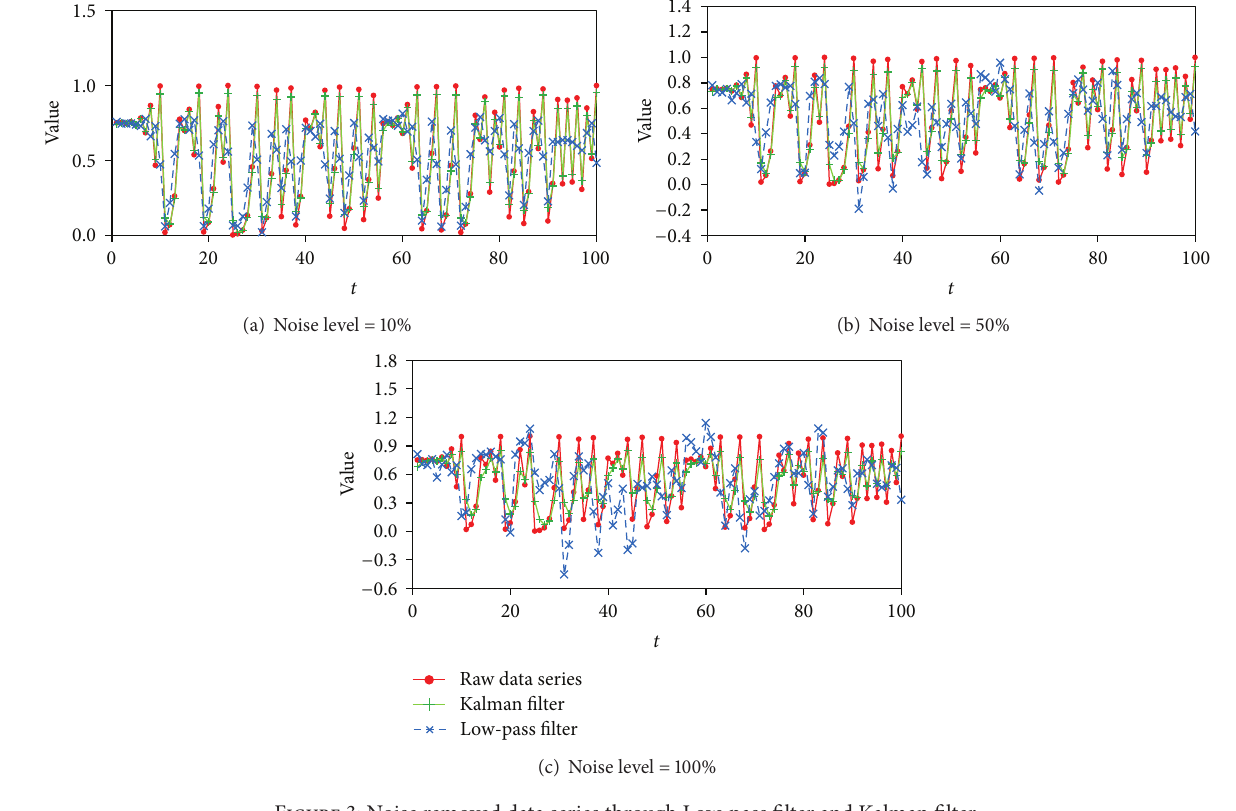
Figure 3: Noise removed data series through Low-pass filter and Kalman filter. Table 1: Statistical characteristics of Logistic series after applying the filtering techniques. Low-pass filter Kalman filter Coefficient of correlation Standard error Coefficient of correlation Standard